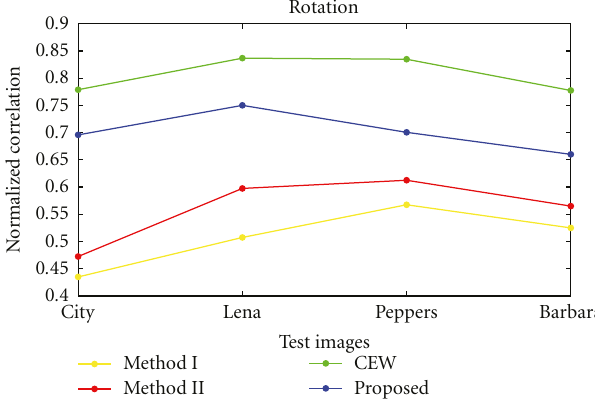
Figure 19: The robustness comparison result of the proposed method with [2, 3] under rotation attack (angle = 6 ◦ ).